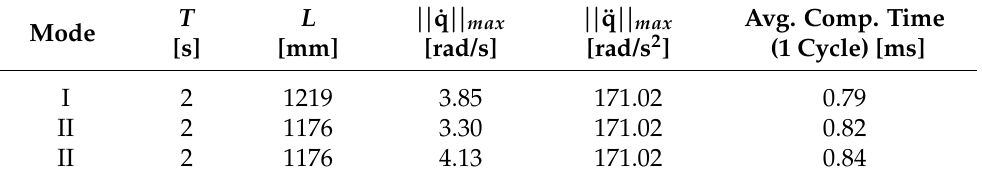
Table 4. Comparison between different modes. Example of Figure